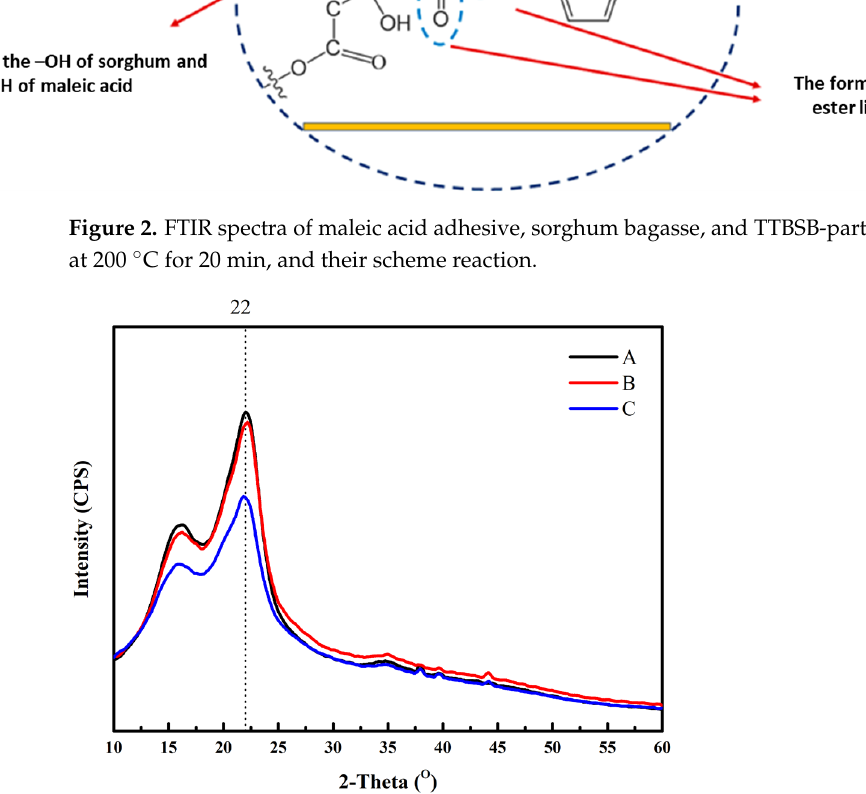
Figure 3. XRD spectra of ( A ) sorghum bagasse, ( B ) TTBSB-particleboard prepared at 180 °C for 10 min, and ( C ) TTBSB-particleboard prepared at 200 °C for 20 min.